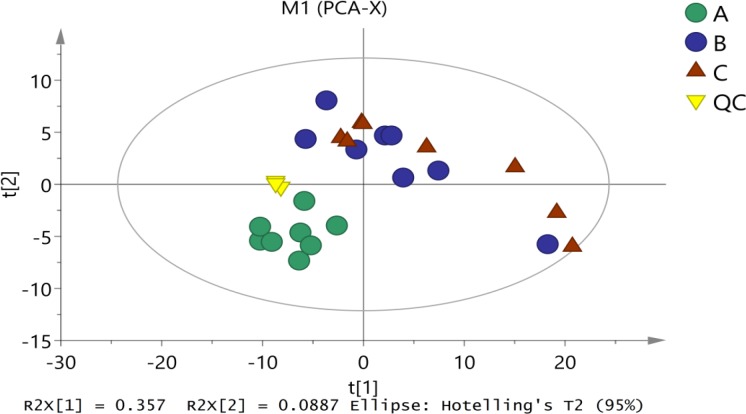
The score plots of PCA for metabolite profiles in P. tuoliensis mycelia. A, Mycelia A samples; B, Mycelia B samples; C, Mycelia C samples; QC, quality control sample.